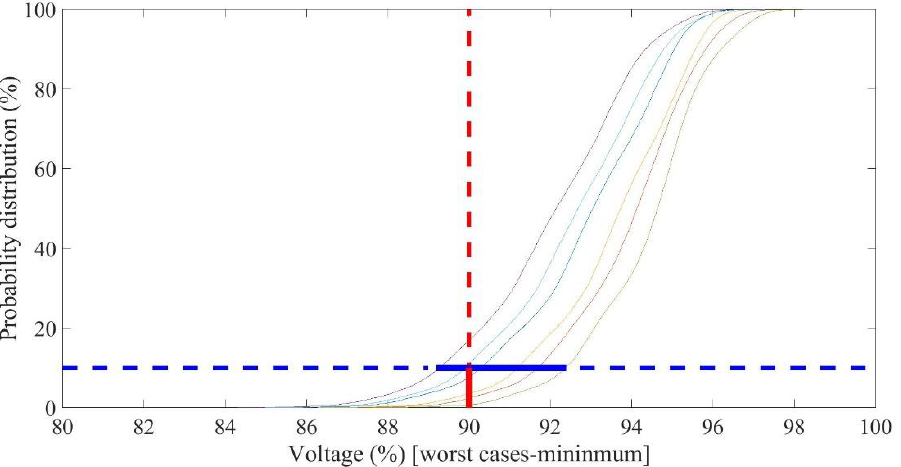
Figure 4. The customers’ voltage probability distribution functions for the 6-customers distribution network. Each of the curves in the figure represents the voltage distribution of a single customer.